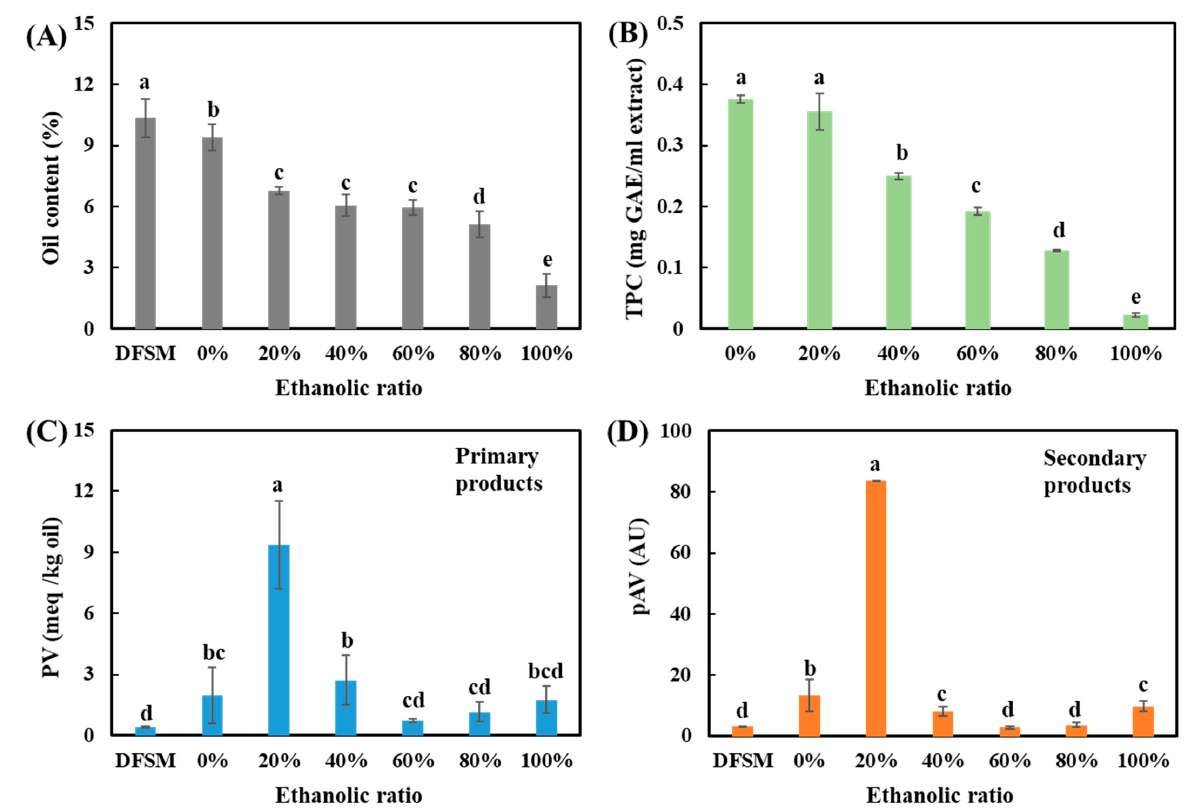
Figure 4. ( A ) Oil content of defatted soy meal (DFSM) and all the soy protein concentrates (SPCs); ( B ) total phenolic content (TPC) of all the extracts; ( C ) hydroperoxide concentration (PV); ( D ) p -anisidine value (pAV) of soybean oil contained in DFSM and SPCs. The values in the figure are compared and different top letters (a,b,c,d,e) indicate a significant difference ( p < 0.05).